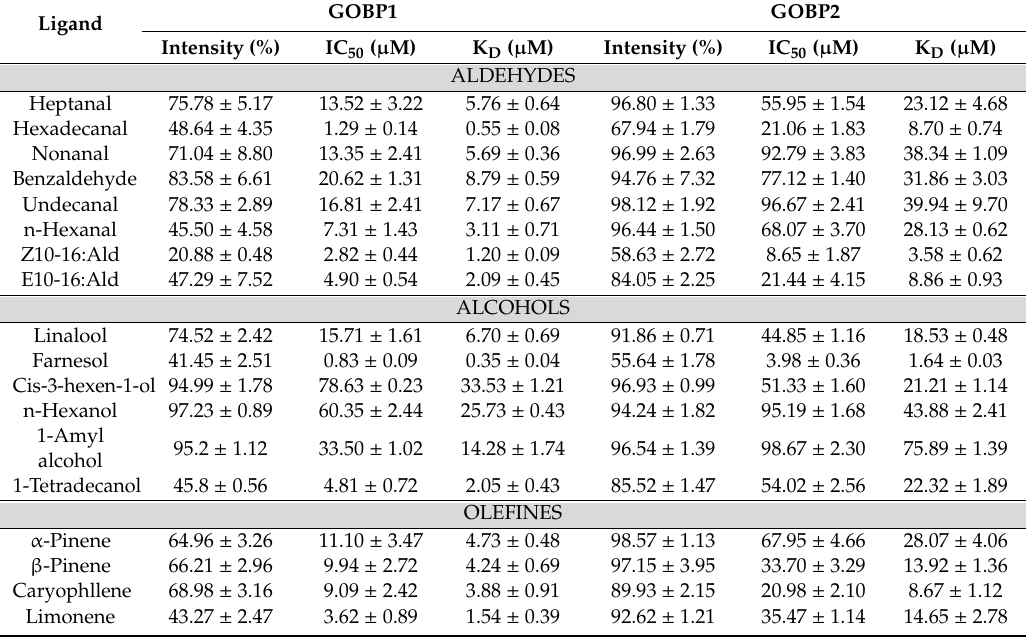
Table 1. IC 50 values ( µ M) and dissociation constants (K D ) ( µ M) of GOBP1 and GOBP2 to di ff erent ligands at pH =